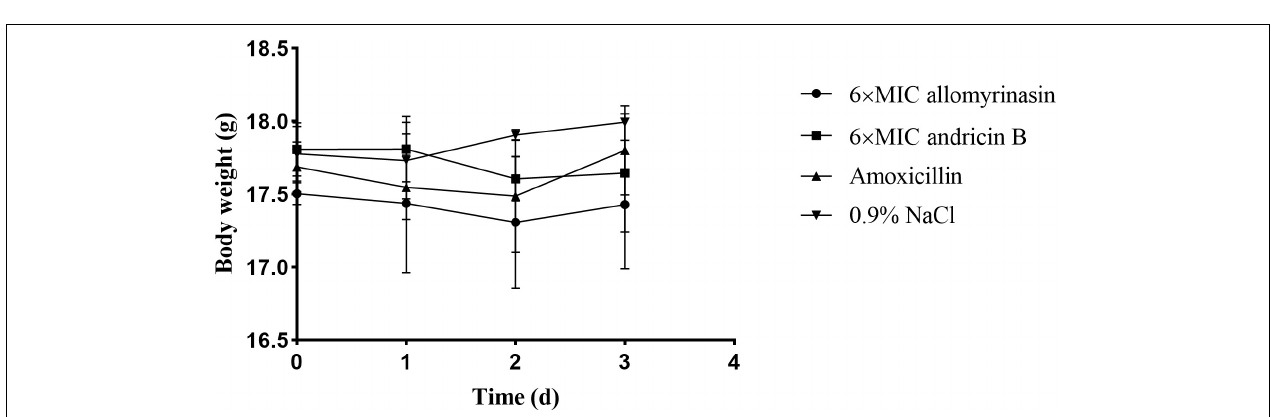
FIGURE 8 | Body weights of mice in different groups treated with allomyrinasin, andricin B, amoxicillin, and saline at 6 × minimal inhibitory concentration (MIC) in a mouse skin infection model induced by Staphylococcus pseudintermedius MW767056. Data are presented as means ± SD ( n = 5).